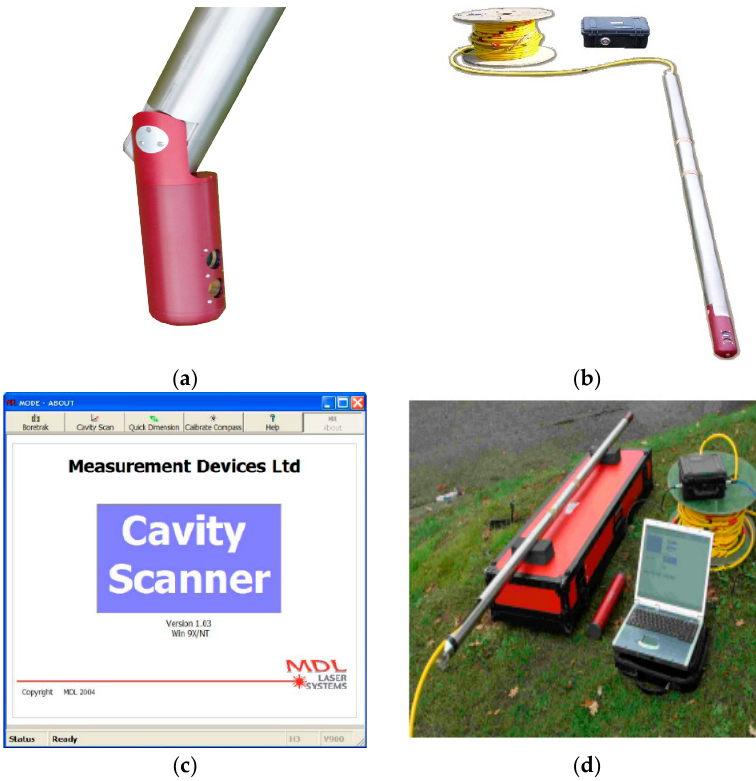
Figure 8. Borehole laser scanning technology (BLST) method: ( a ) laser ranging module; ( b ) integrated detector; ( c ) processing software; ( d ) the whole system. detector; ( c ) processing software; ( d ) the whole